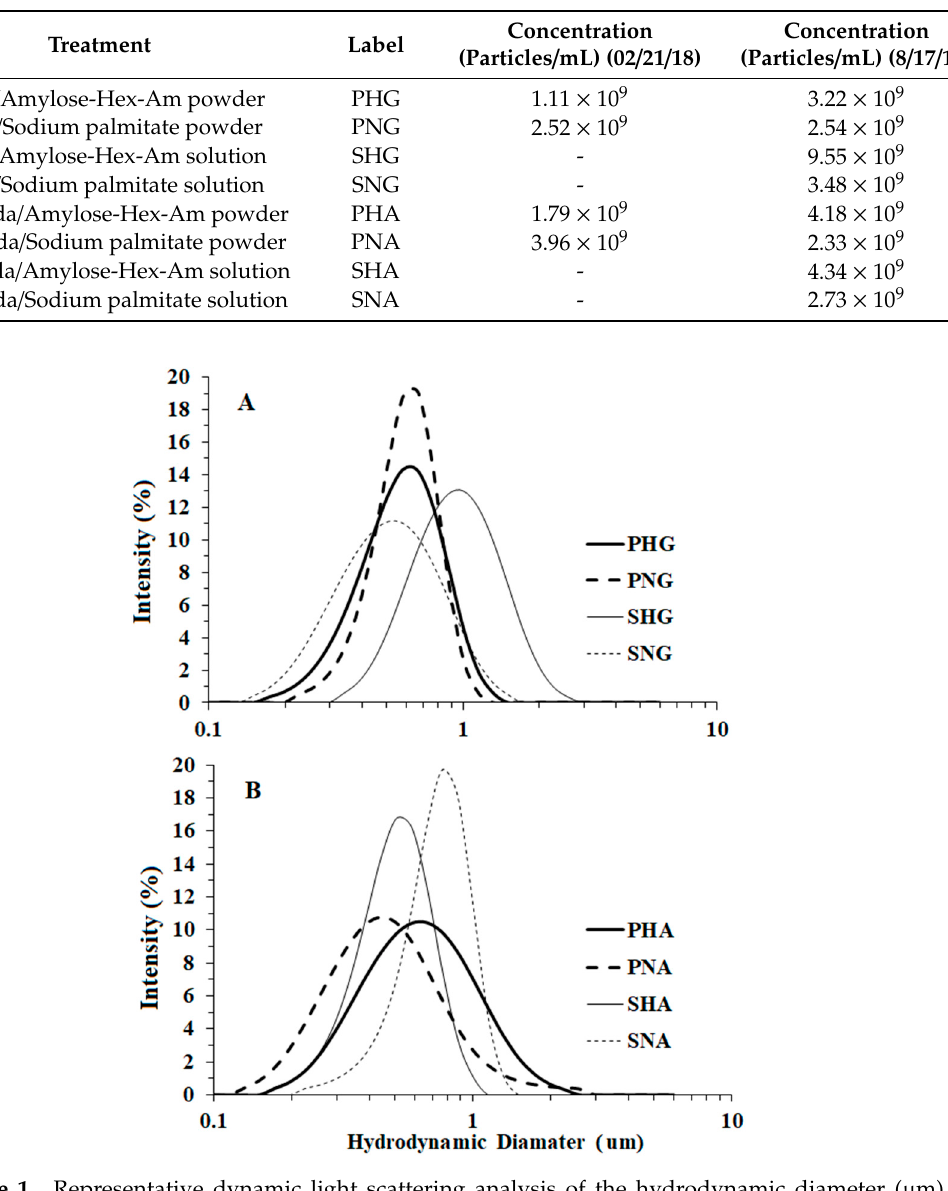
Figure 1. Representative dynamic light scattering analysis of the hydrodynamic diameter (µm) of